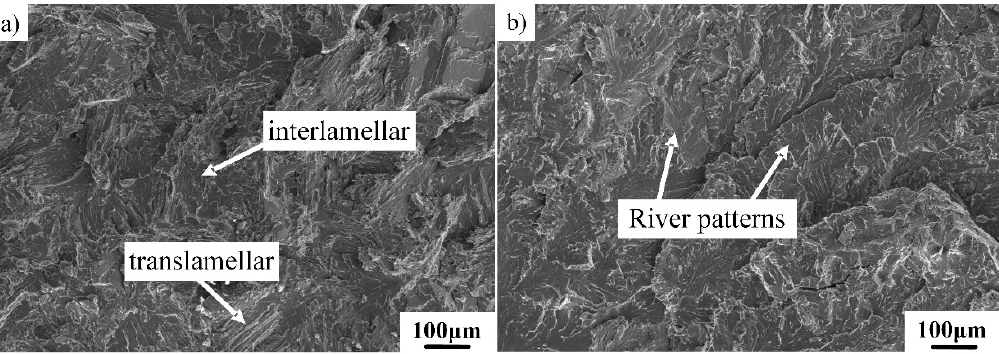
Figure 10. RT tensile fracture surfaces of Ti–43Al–2Cr–2Mn–0.2Y alloy with FL microstructure: ( a ) fracture feature and ( b ) river patterns.